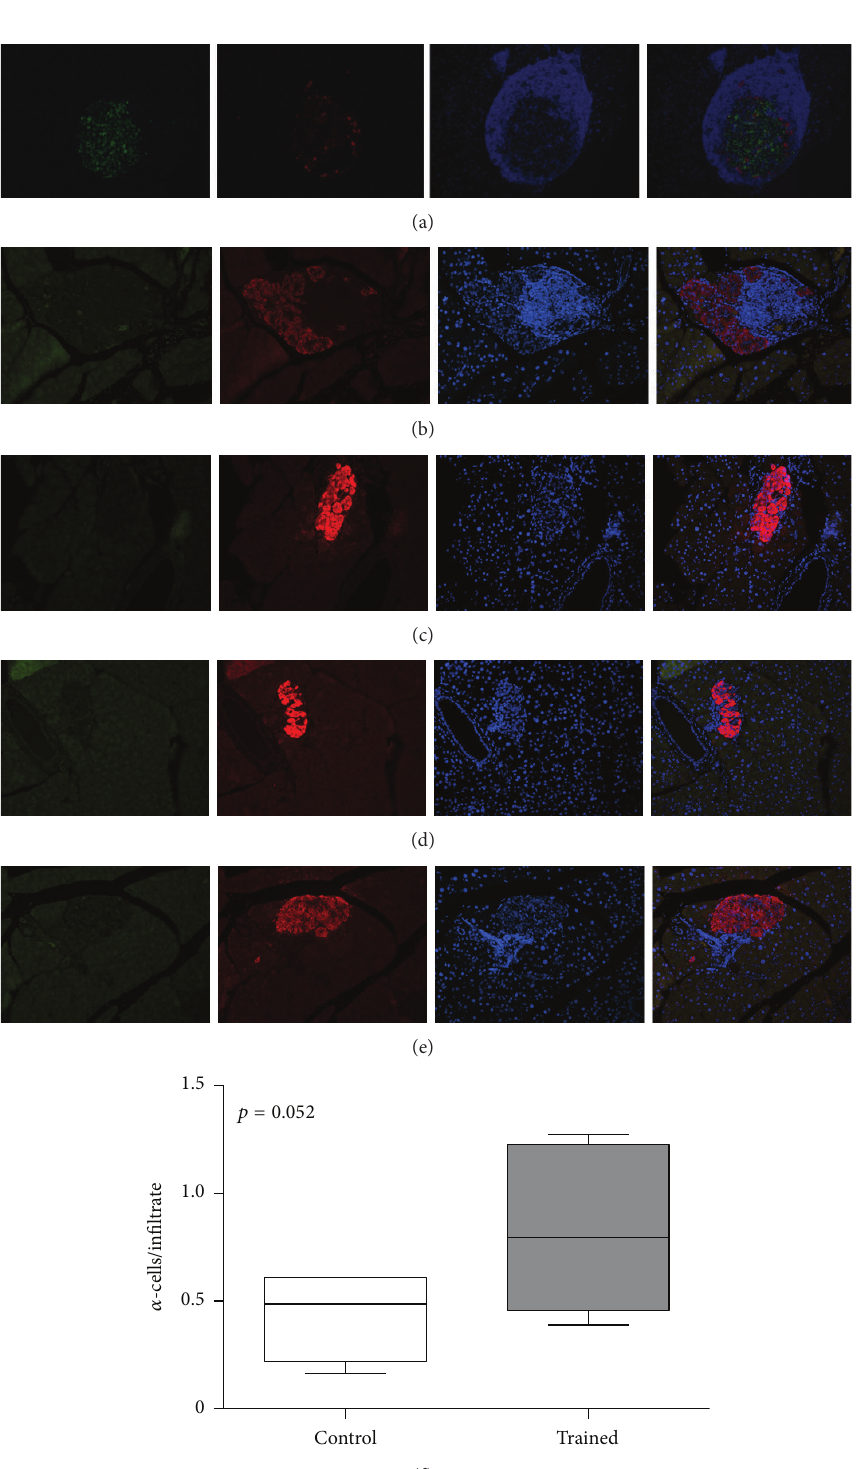
Figure 6: (a) Islet of Langerhans visualized by immunofluorescence microscopy. This figure is a representative immunostaining of pancreatic sections, from a NOD diabetic mouse after 6 weeks of exercise. The entire tissue section is captured by a modified method of “virtual slice image capture” using a microscope with a 10x objective. Each virtual slice taken at multiple fluorescent channels is merged into one composite, shown as insulin (green), glucagon (red), and DAPI for the nuclei. Quantitatively, the cell composition of these mouse islets was more than 70% 𝛽 -cells and less than 20% 𝛼 -cells. Analysis of the immune infiltrates (blue) in the pancreatic islets of diabetic untrained (b) or trained (c) animals at 12th week of exercise (20x objective). (d, e) Analysis of the pancreatic islets of two mice died at week 10 of exercise because of earlier diabetic incidence (occurred at 7th week of training) (20x objective). (f) Whiskers plot of the ratio 𝛼 -cells/infiltrate in controls and trained mice at the end of the 12 weeks of